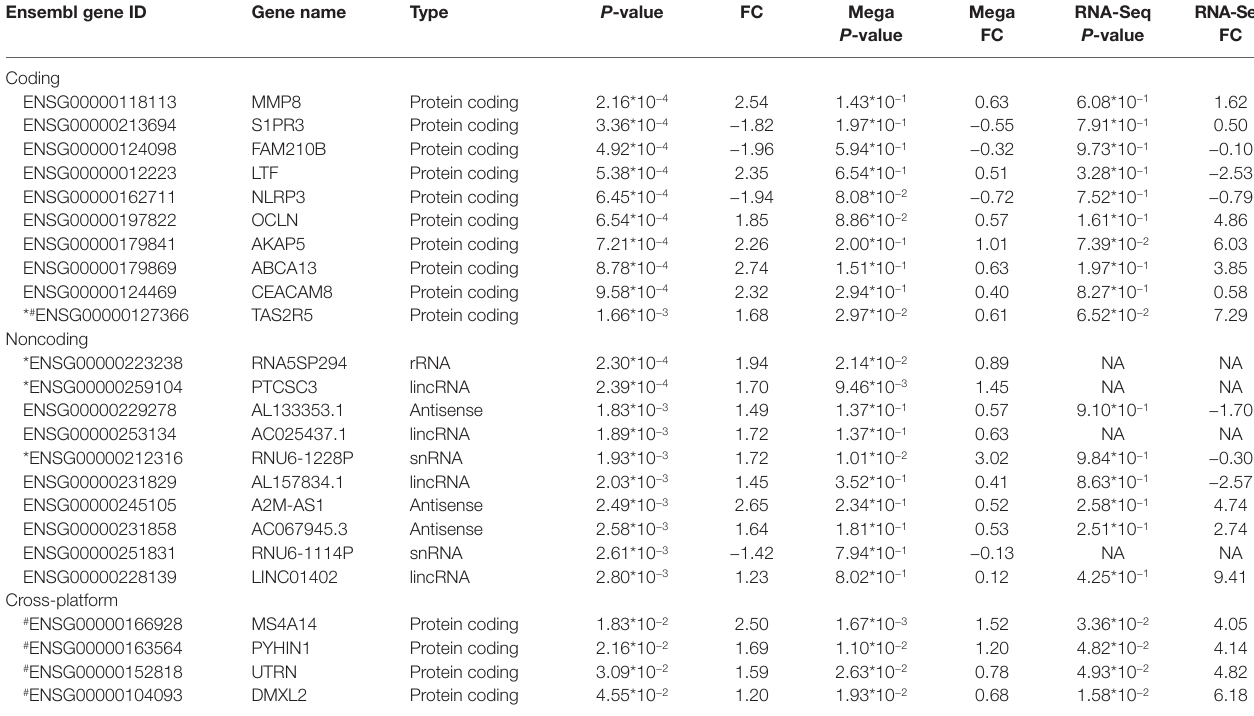
TABLE 2 | Top 10 significant coding and noncoding differentially expressed genes (DEGs) in HTA and their performance on different platforms.